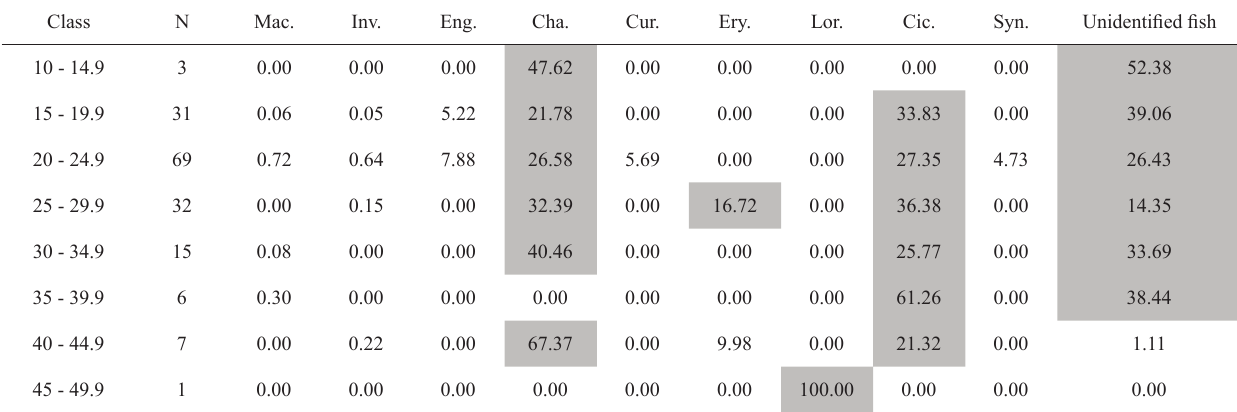
Fig. 1. Resource accumulation curves controlled by the number of stomachs of Cichla piquiti analyzed, considering all fish (a), sexes (b), maturity (c) and season (d). Sample size was reduced to 67 stomachs because this analysis considered only resources identified at some independent level, removing unidentified or combined items. Table 3. Feeding resources (percent volume) consumed by different length classes (standard length SL, cm of Cichla piquiti ). Resources are grouped in families or groups. Values above 10% are highlighted in gray. N = sample size. Mac. = macrophytes; Inv. = invertebrates; Eng. = Engraulidae; Cha. = Characidae; Cur. = Curimatidae; Ery. = Erythrinidae; Lor. = Loricariidae; Cic. = Cichlidae; Syn. =